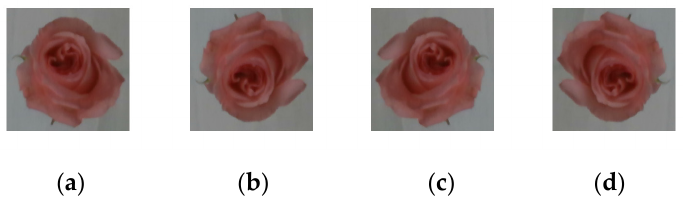
Figure 4. Flower data expansion, where ( a ) is the original image, ( b ) is after horizontal flipping, ( c ) is after vertical flipping, and ( d ) is after diagonal mirror flipping. Table 3. Sample dataset distribution.